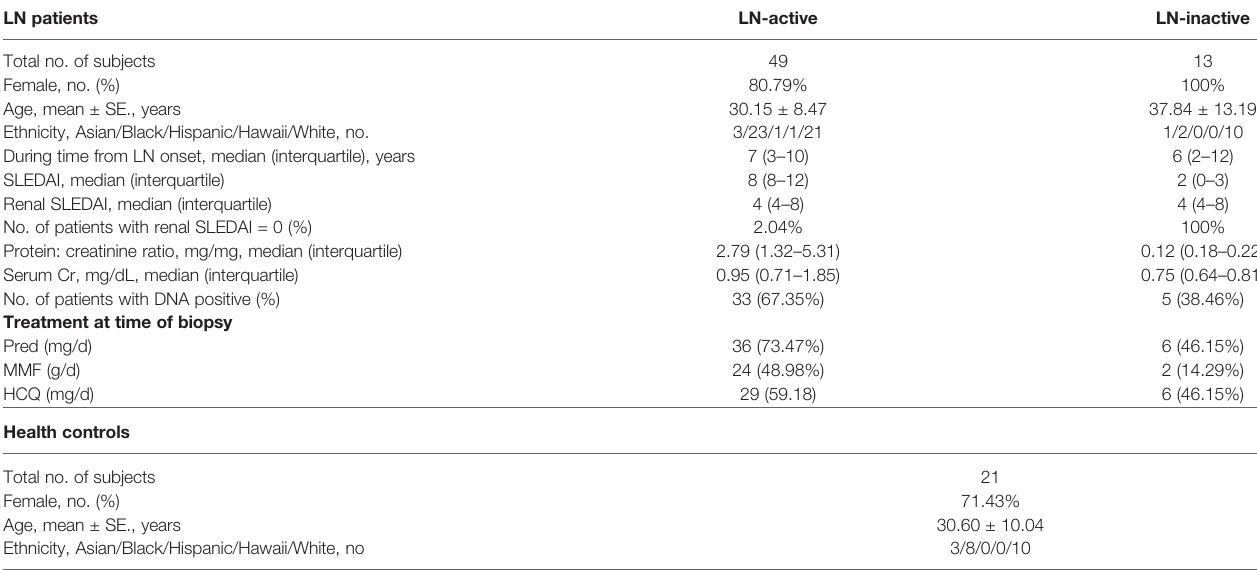
TABLE 1 | Demographics and clinical characteristics of